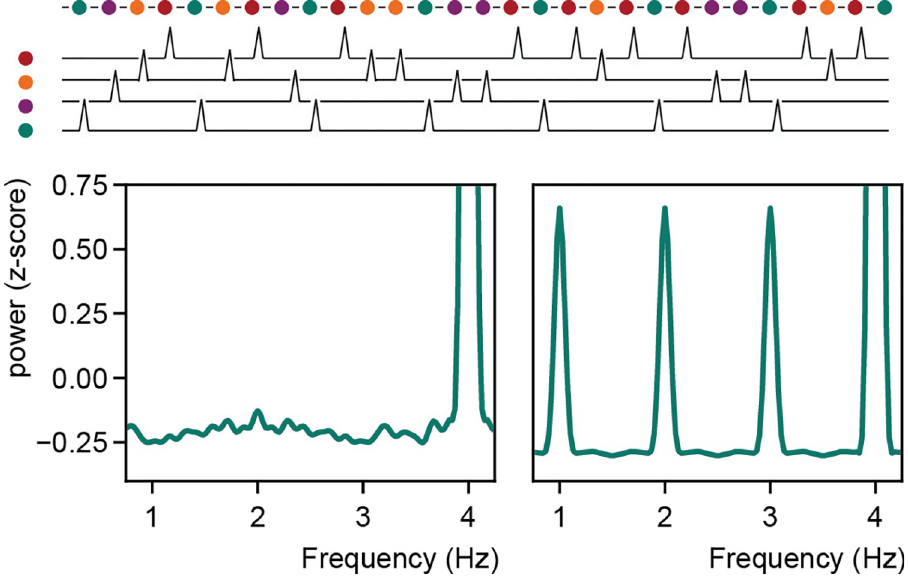
Fig 2. SSVEP studies do not assume any integration of responses. When multiple category stimuli (here different colors) are presented with all a stereotypical response, a low frequency response will occur if any of them is presented at a specific rate (here green). Left: all items randomly presented. Right: single item is presented at a 1-Hz rate.